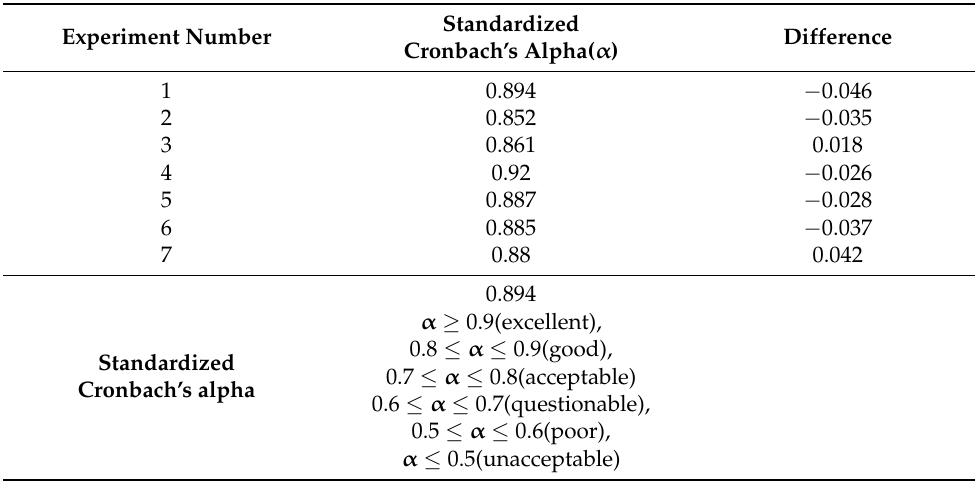
Figure 13. Comparison of the Bragg wavelength shift with and without the use of a long-period grating. Table 1. Sensor reliability results for repetitive motion.